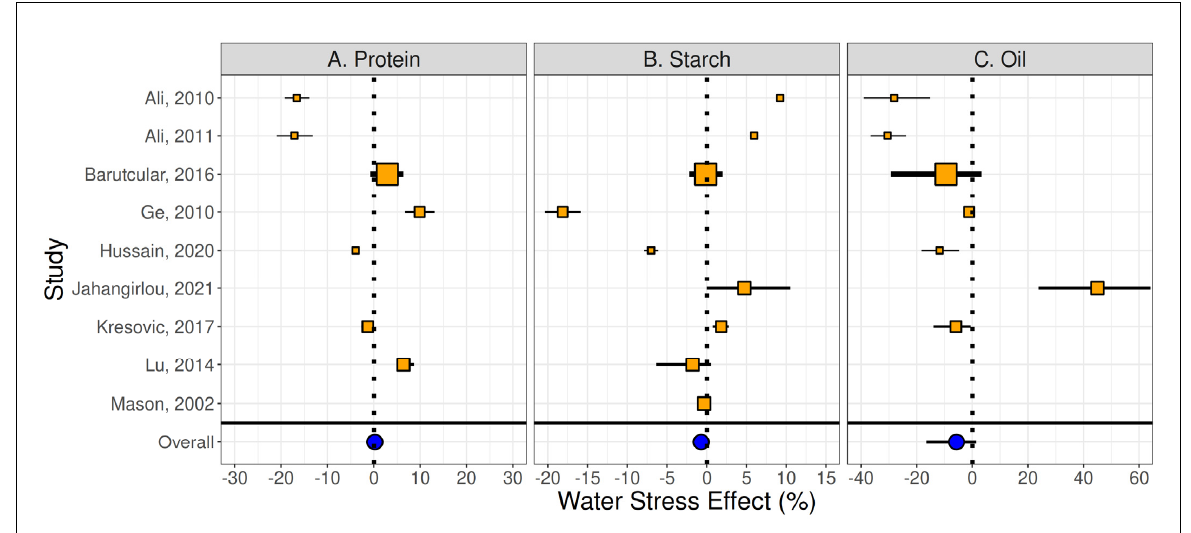
Figure 3. Summary of water stress effect (%) on maize grain quality components (( A )—Protein, ( B )—Starch, and ( C )—Oil, all expressed in concentrations, %). Effect sizes and 95% confidence intervals (CI) were transformed from lnRR into percentage [(exp(lnRR) − 1)*100], as the concentration variation in water-stressed with respect to well-watered control. Within each variable, orange square symbols represent the mean effect per study, while shape size and whiskers represent their respective weights, and uncertainties, respectively. Blue circles represent the overall random effects model with their respective uncertainties.